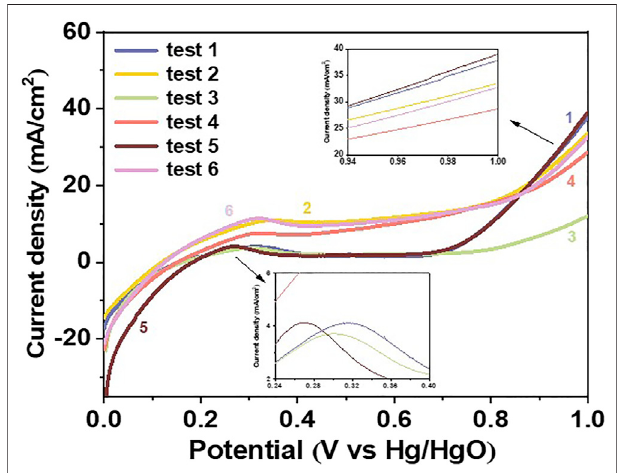
FIGURE 7 | LSV curves of Ti/PbO 2 anode under different conditions to analyzetheanodedeactivation mechanism. Test(1)Ti/PbO 2 -NaOHsolution; (2) Ti/PbO 2 -lignin-NaOH solution; (3) Deactivated Ti/PbO 2 - lignin-NaOH solution after CA test; (4) new Ti/PbO 2 - lignin-NaOH solution after CA test; (5) new Ti/PbO 2 -new NaOH solution; (6) Deactivated Ti/PbO 2 -new lignin-NaOH solution. Experimental conditions: temperature 60 ° C, 1 mol/L NaOH, counter electrode Pt. Initial concentration of lignin is 10